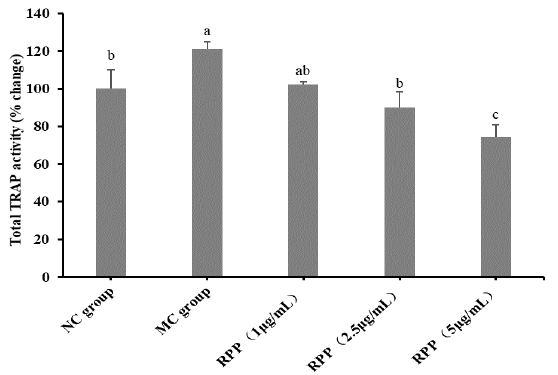
Figure 3. Quantitative assessment of TRAP-positive activity. Groups with different letters are significantly different ( p < 0.05).